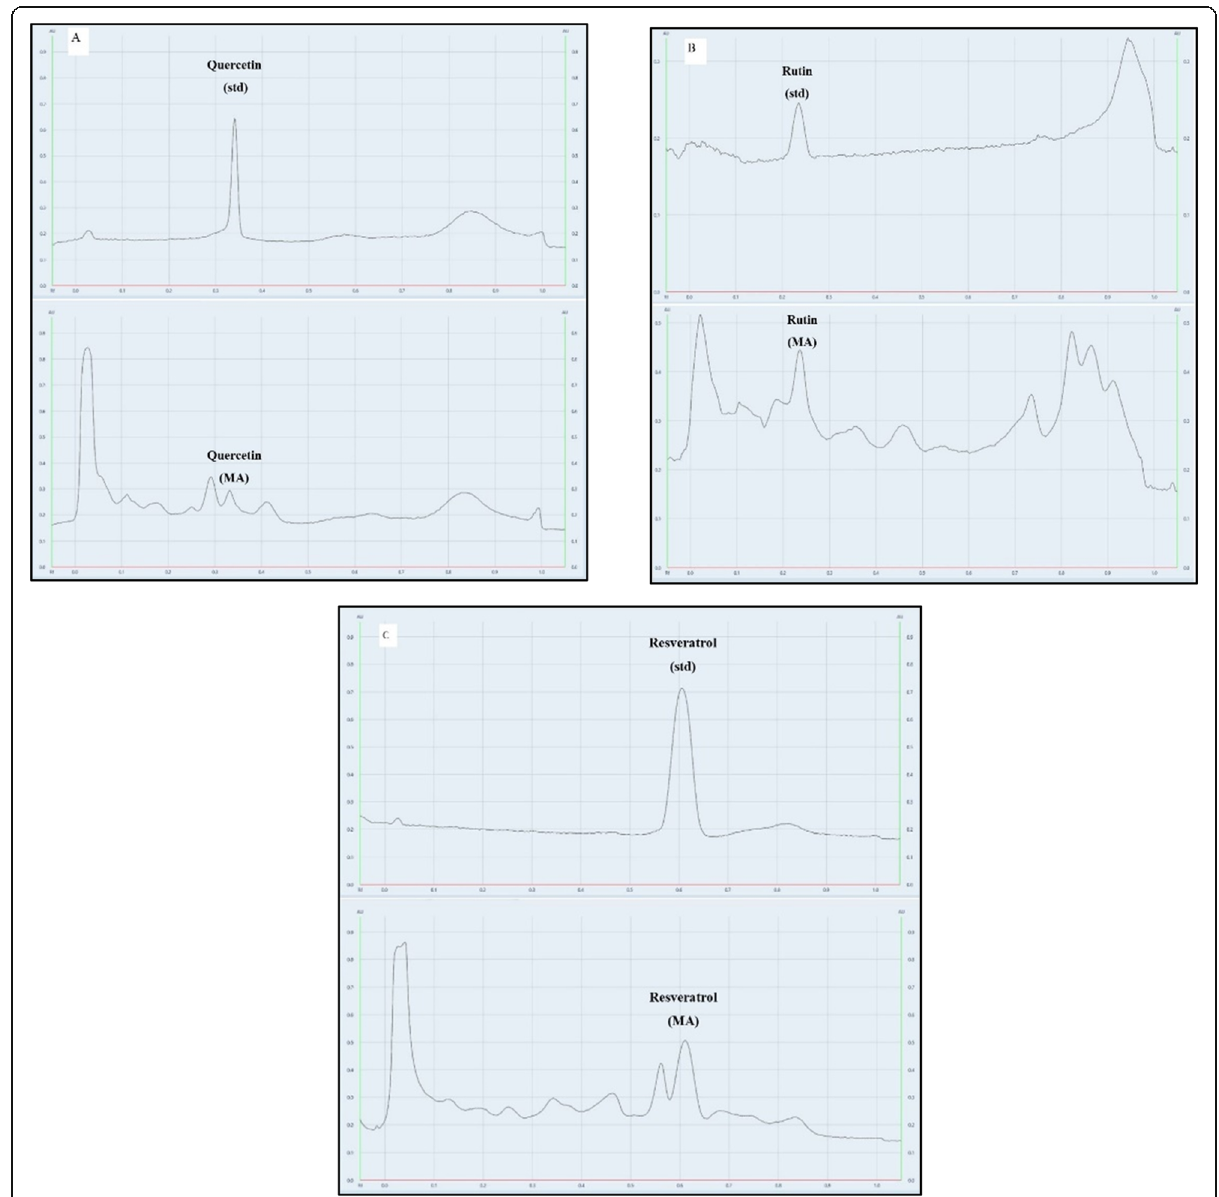
Fig. 1 Fingerprint chromatogram of standard marker compounds and MA. a Fingerprint of quercetin standard (std) and MA at 262 nm. b Fingerprint of rutin (std) and MA at 262 nm. c Fingerprint of resveratrol (std) and MA at 302